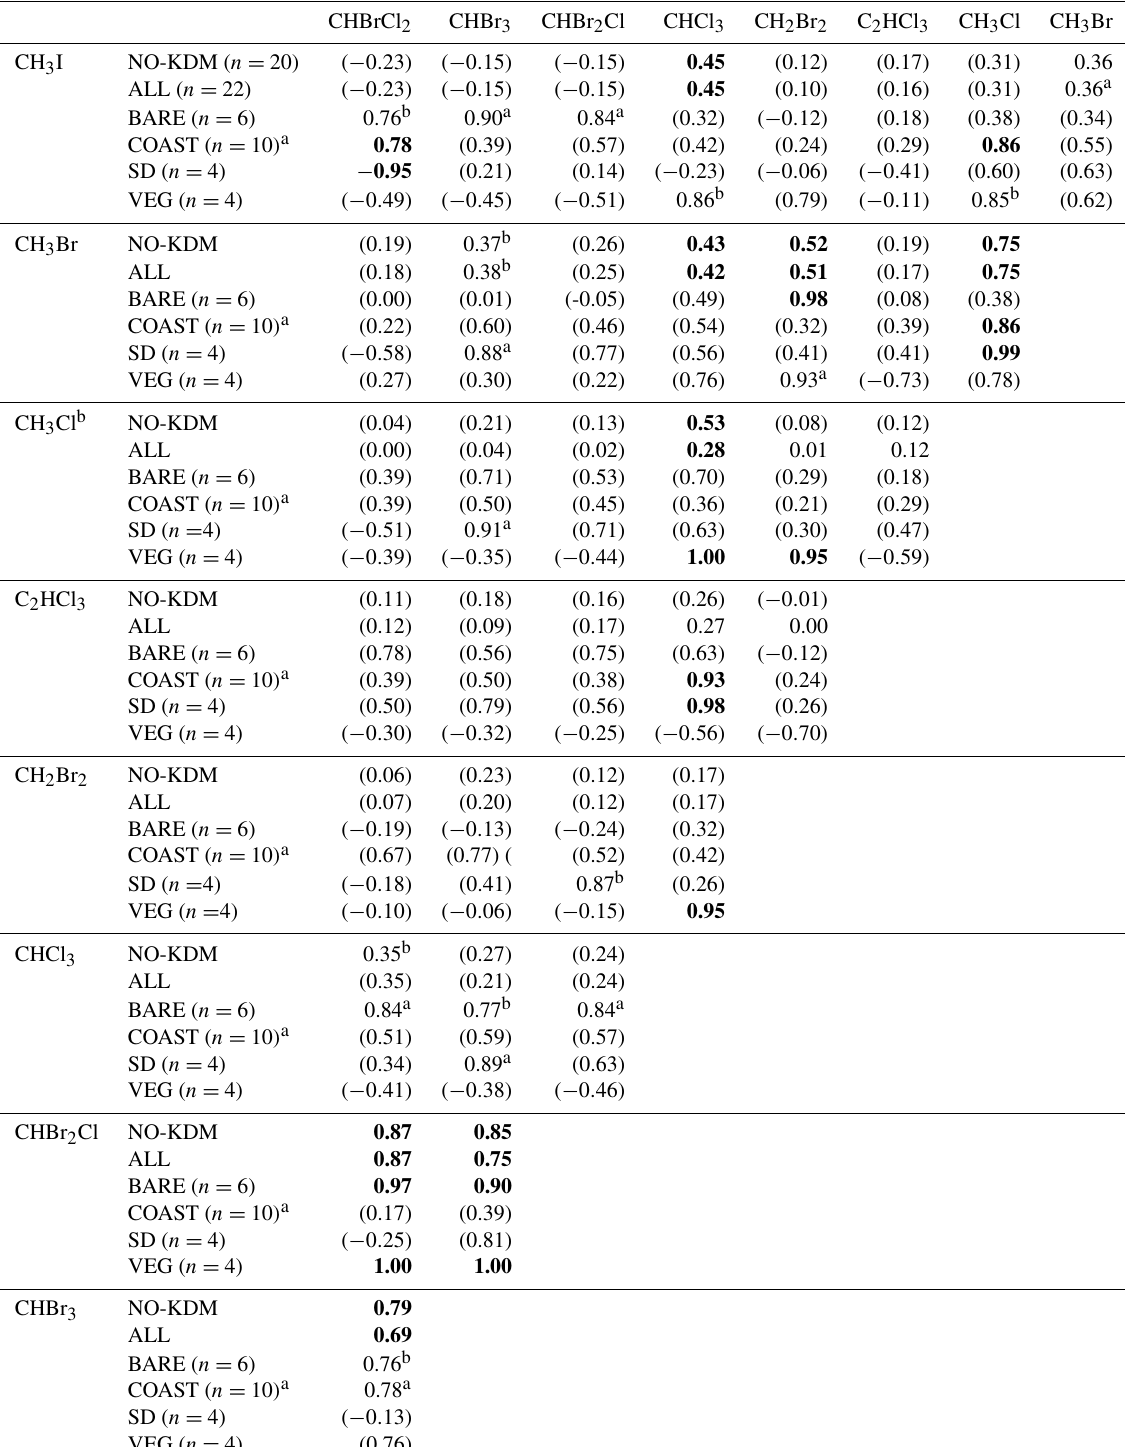
Table 4. Correlations between the mixing ratios of VHOCs. Shown is the Pearson correlation coefficient ( r ) between each VHOC pair for the measured mixing ratio, when calculated over all sites excluding SEA–KDM (NO-KDM), all sites (ALL), bare soil sites (BARE), coastal sites (COAST), short distance from the sea at the coastal sites (SD) and the vegetated sites (VEG). Correlations were calculated for mean mixing ratios at each site. The p value for r being significantly different from zero is indicated based on one-sample t test, in four categories. For values in bold, p < 0 . 05. For values in parentheses, p >0.15. a p (cid:28) 0 . 1. b p